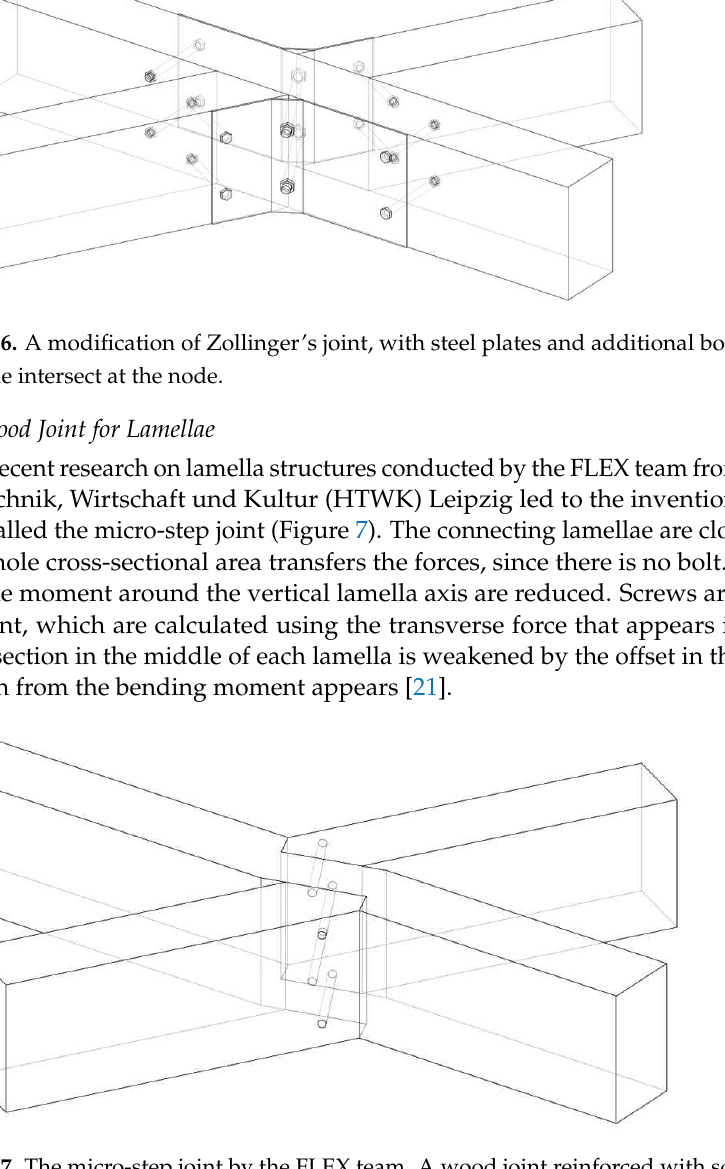
Figure 6. A modification of Zollinger's joint, with steel plates and additional bolts. The axes of the lamellae intersect at the node.